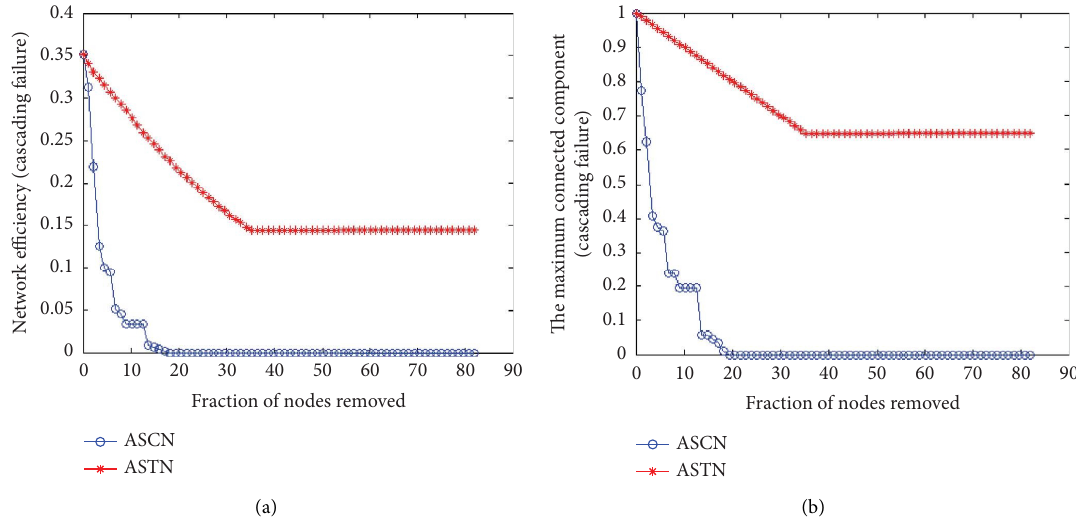
Figure 14: Te robustness of ACMN under cascading failure. (a) Network efciency (cascading). (b) Maximum connected component